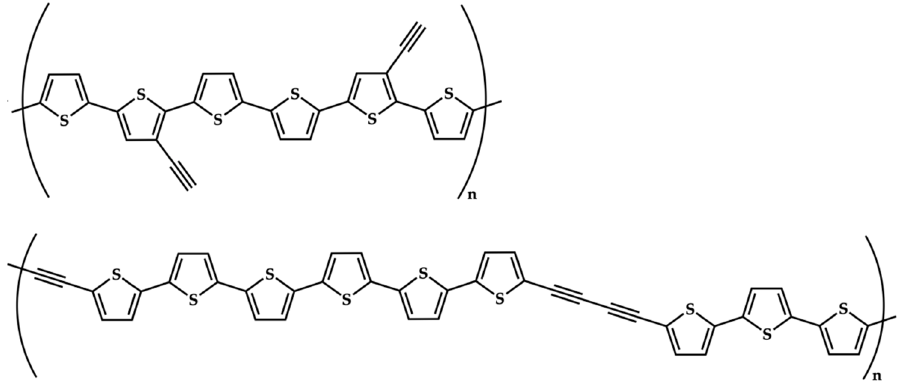
Figure 7. Plausible coupling of terthiophene fragments in poly- 3 ′ -ET (top) and in poly- 5-ET (bot-